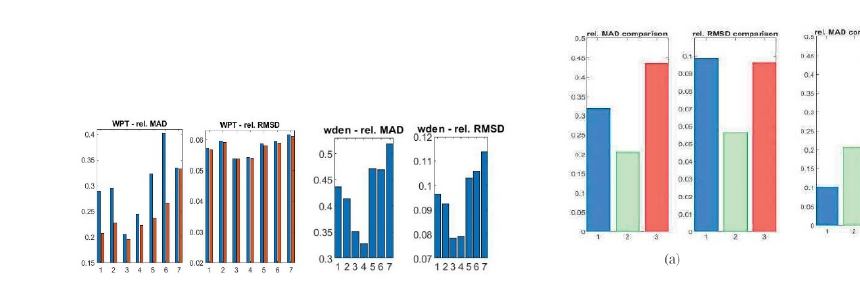
Figure 19. Comparison of mean rel. MAD (left) and rel. RMSD (right) for all cases of wavelet- based denoising: top - with WPT (with edges – blue, without edges - red) and bottom – with wden . On ox axis: 1 - > no slope; 2...4 - > as- cending slope (0.02, 0.04 , 0.06); 5...7 - > de- scending slope: (-0.02, -0.04 , - 0.06).